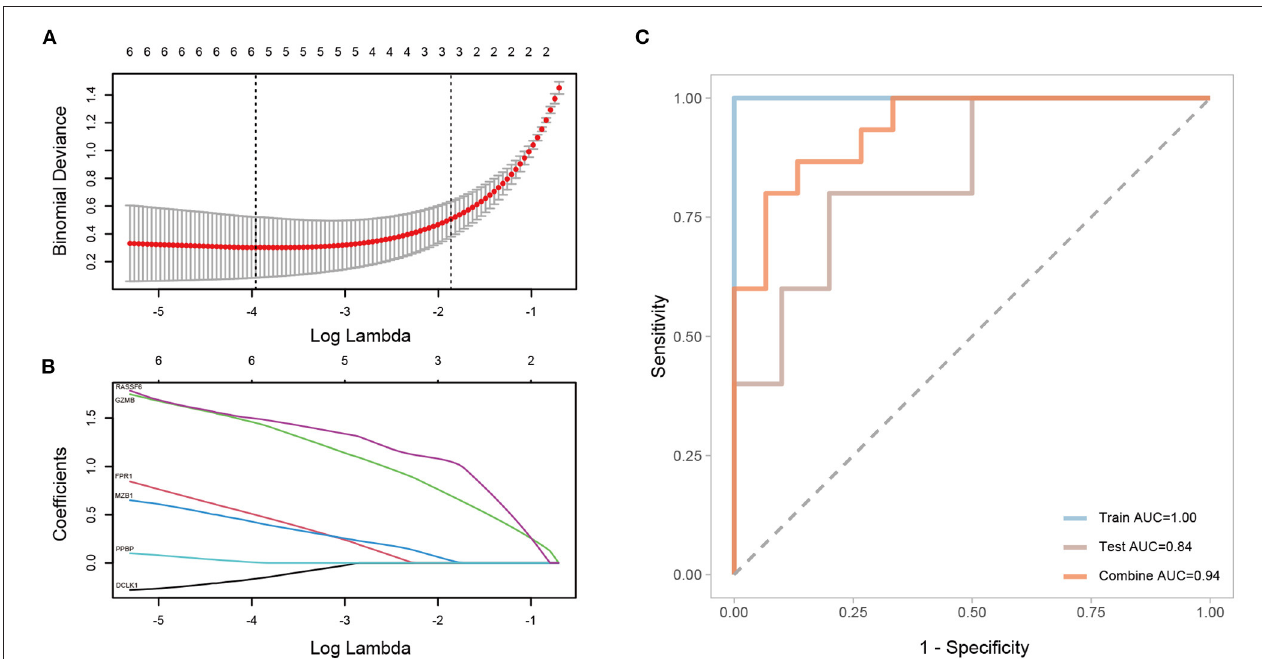
FIGURE 11 | Construction and validation of a LASSO regression model. (A,B) Selected genes and their coefficients according to minimum binominal deviance. (C) ROC analysis of the LASSO regression model with the training set, validation set, and both sets